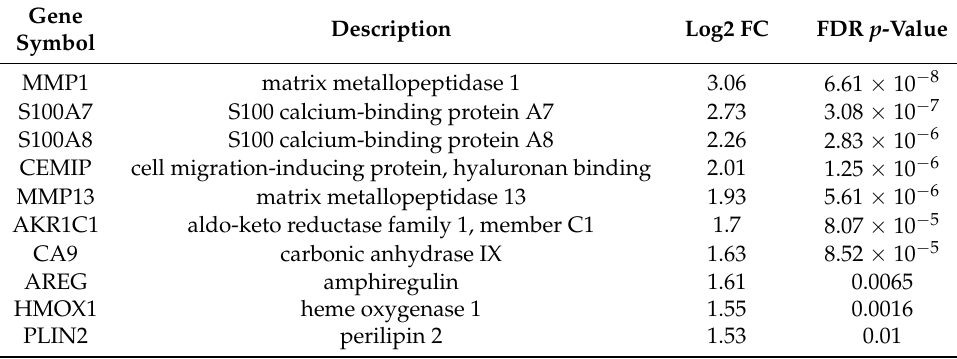
Table 1. Top ten upregulated genes in spheroids transfected with miR193a.